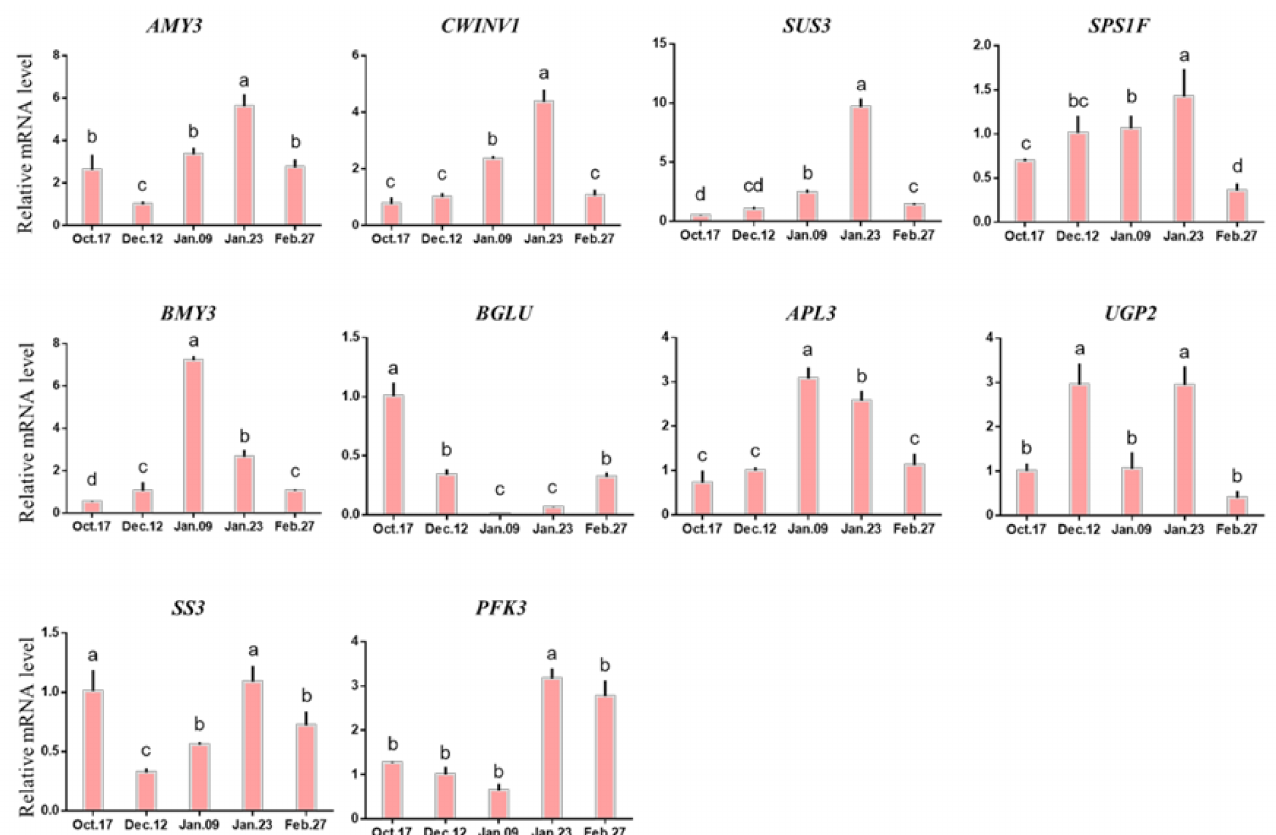
Figure 8. Expression of the genes involved in carbohydrate metabolism during bud dormancy of ‘Meiju’. Each bar represents the mean ± SEM ( n = 3). Different letters indicate a significant difference among different dates ( p < 0.05). The experimental time was from 2018 to 2019, and the data were processed by IBM SPSS Statistics